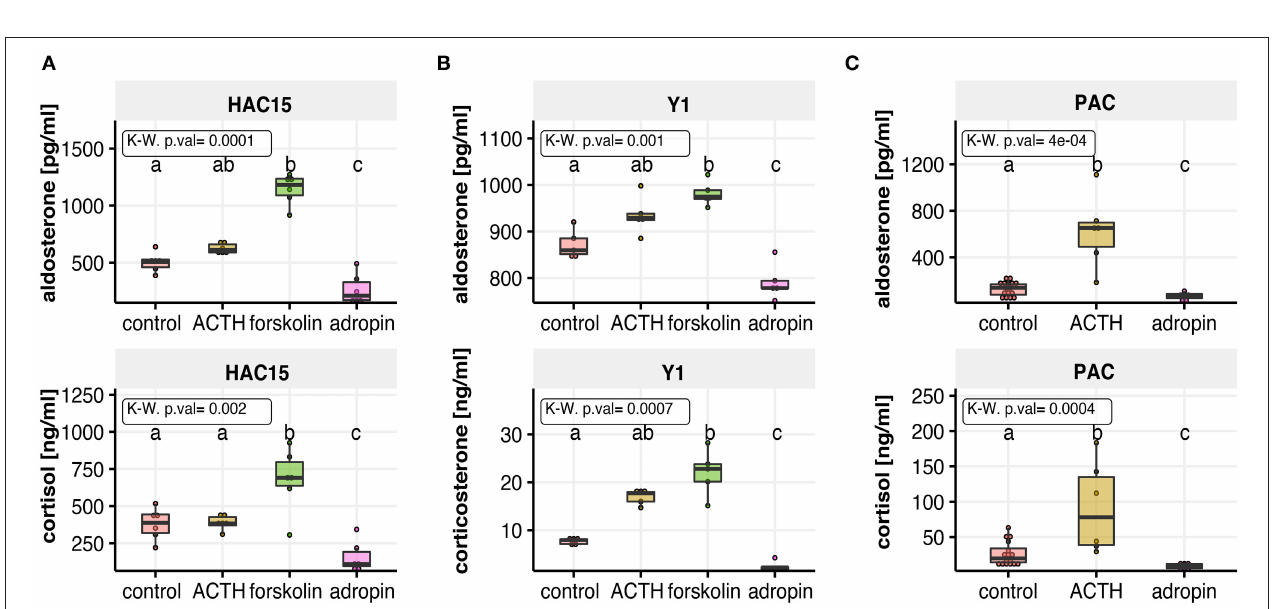
FIGURE 1 | Relative expression levels of the adropin precursor gene ENHO and the adropin receptor GPR19 in HAC15 cells. (A) Real time qPCR study in untreated (control) cells and cells incubated with ACTH, forskolin, and adropin for 24h ( N = 4/group). Statistical differences were determined by Mann–Whitney U non-parametric test compared to controls. Both the expression of ENHO and GPR19 did not differ significantly from the control group. (B) GPR19 immunoreactivity in untreated HAC15 cells. The reaction was detected in cytoplasmic vesicles and cell membranes (indicated by white arrows). (C) Semi-quantitative analysis of GPR19 expression at protein level using western blot method.